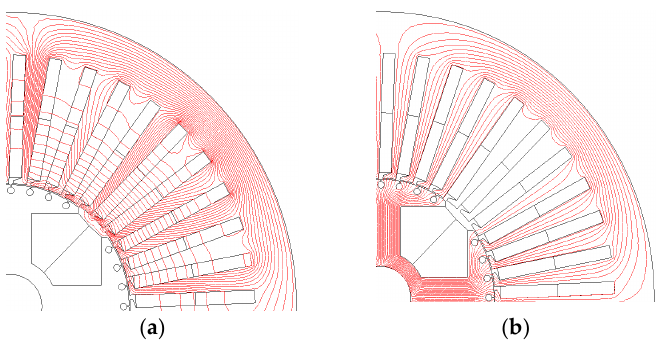
Figure 8. Flux distribution of the SPSM. ( a ) d -axis self-leakage flux line, ( b ) only field winding excitation flux line.